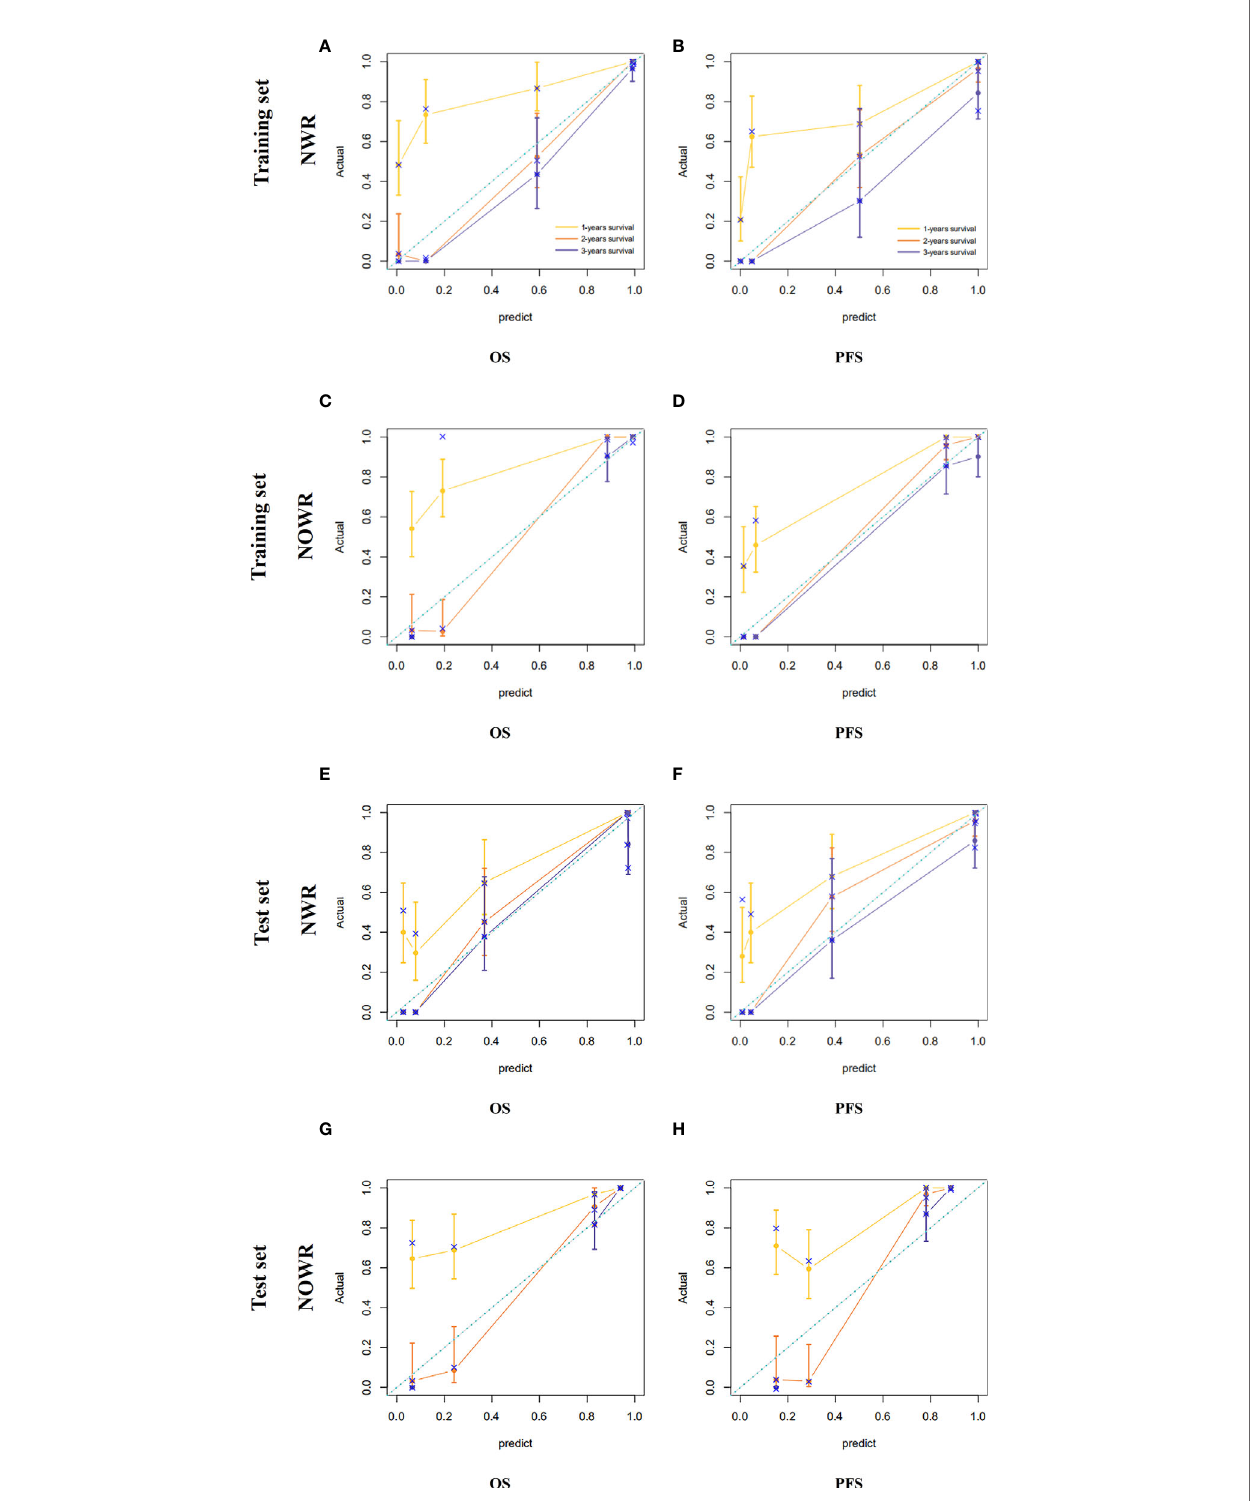
FIGURE 4 | Calibration curve of the NWR for OS (A) and PFS (B) in the training set. Calibration curve of the NOWR for OS (C) and PFS (D) in the training set. Calibration curve of the NWR for OS (E) and PFS (F) in the test set. Calibration curve of the NOWR for OS (G) and PFS (H) in the test